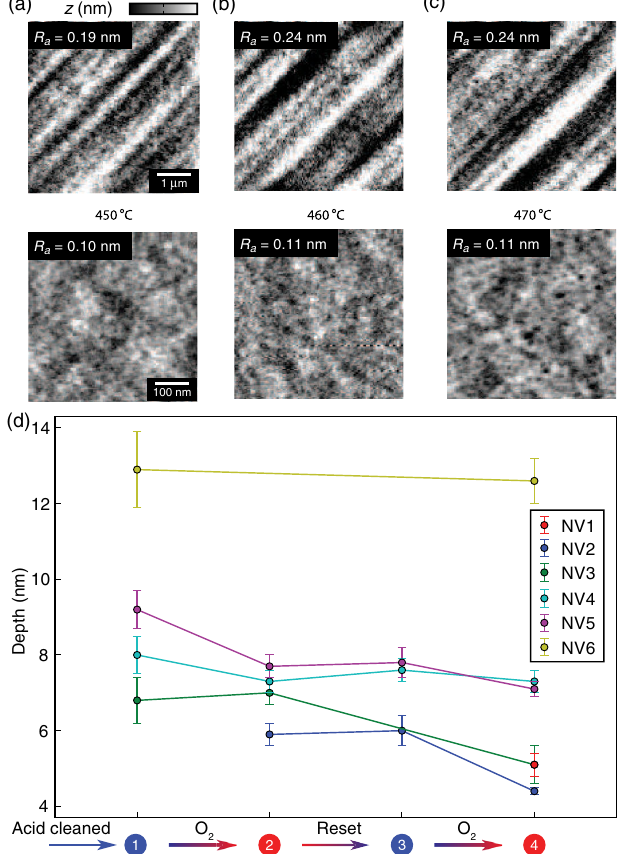
FIG. 7. (a) – (c) AFMimages of a scaife-polished standard grade sample annealed at successively higher temperatures for temper- ature calibration of oxygen furnace. Micropits (black circles about 20 nm in diameter) are visible after the oxygen anneal at 470 °C. (d) Depth measurements of the six NV centers presented in the main text after different annealing steps.